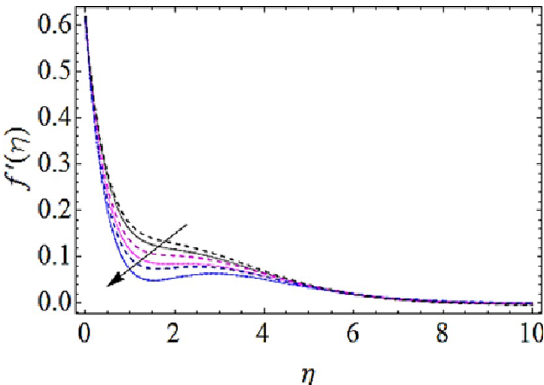
Fig 2. Velocity profiles for different values of magnetic